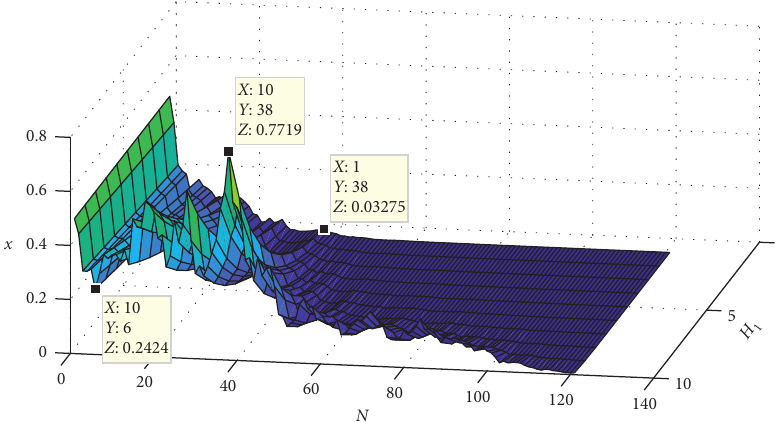
Figure 5: The impact of high subsidy ( H